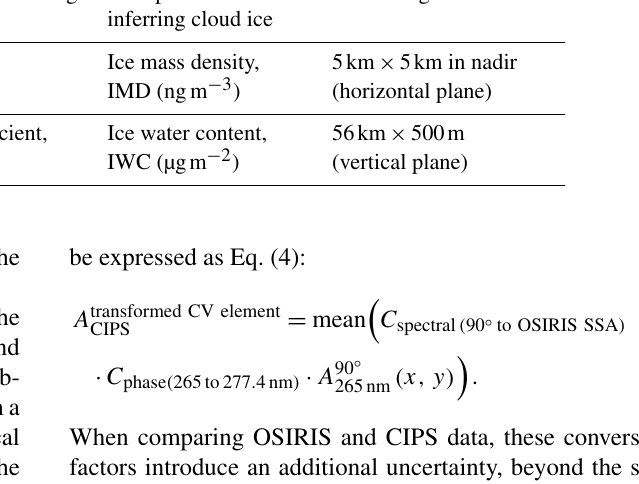
Table 2. Overview of parameters.